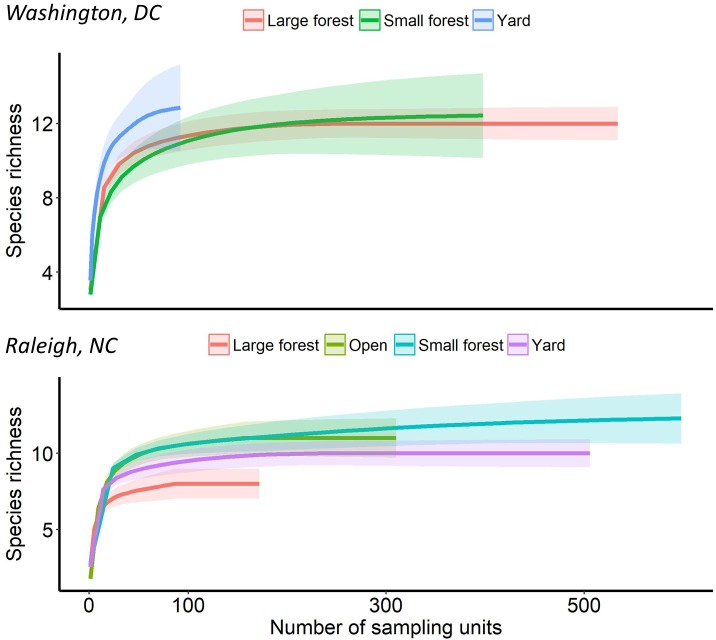
Rarefaction curve estimating species richness in three plot types (residential yard, small forest, large forest) in two cities, Washington, DC and Raleigh, NC, USA, using camera traps between 2012 and 2016.Shaded areas represent 95% confidence intervals.